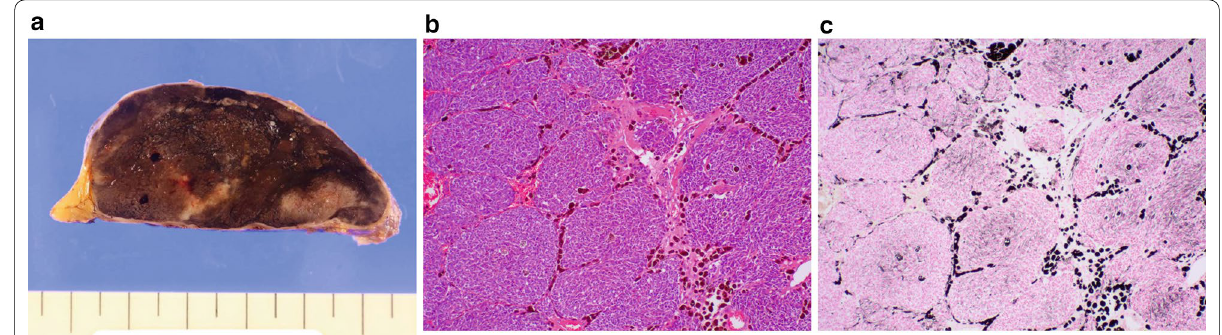
Fig. 2 Gross appearance and histologic findings of the resected tumor. a Dark-brownish cut surface. b Hematoxylin–eosin staining revealing nesting proliferation of the spindle-shaped tumor cells and marked dark-brownish pigmentation in the macrophages. c Fontana–Masson staining confirming melanin in the pigmented